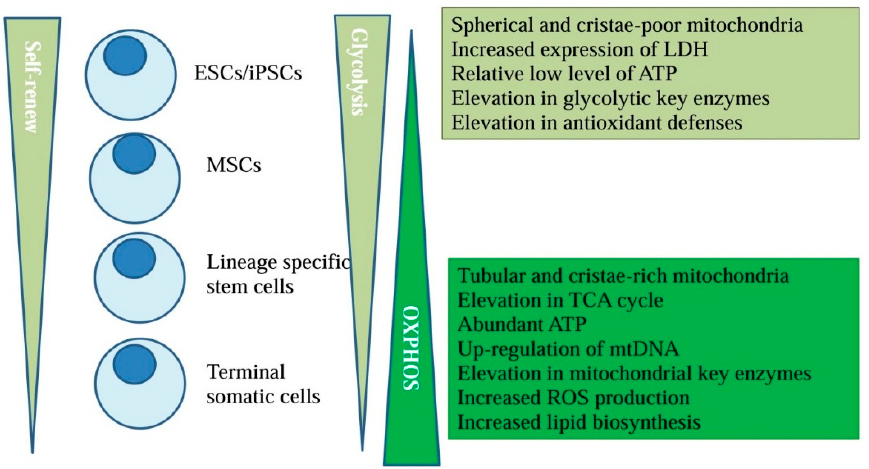
Figure 1. Metabolic pathways may provide important signals to direct the self-renewal and differentiation potency of stem cells.